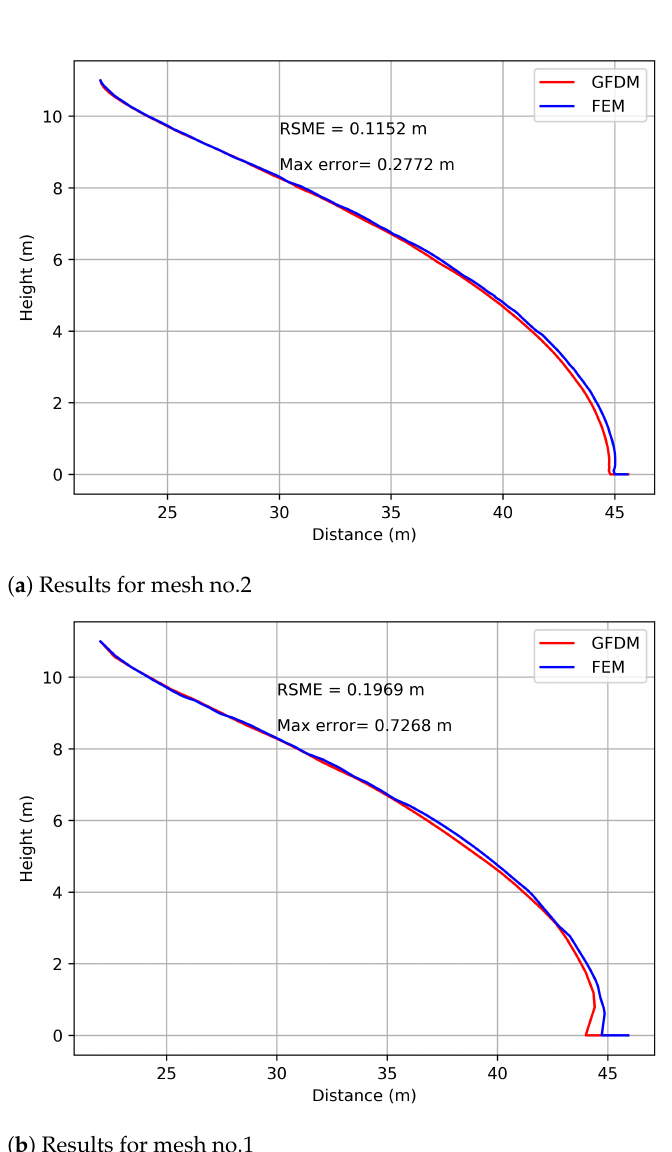
Figure 8. Comparison between the solution of the two methods.